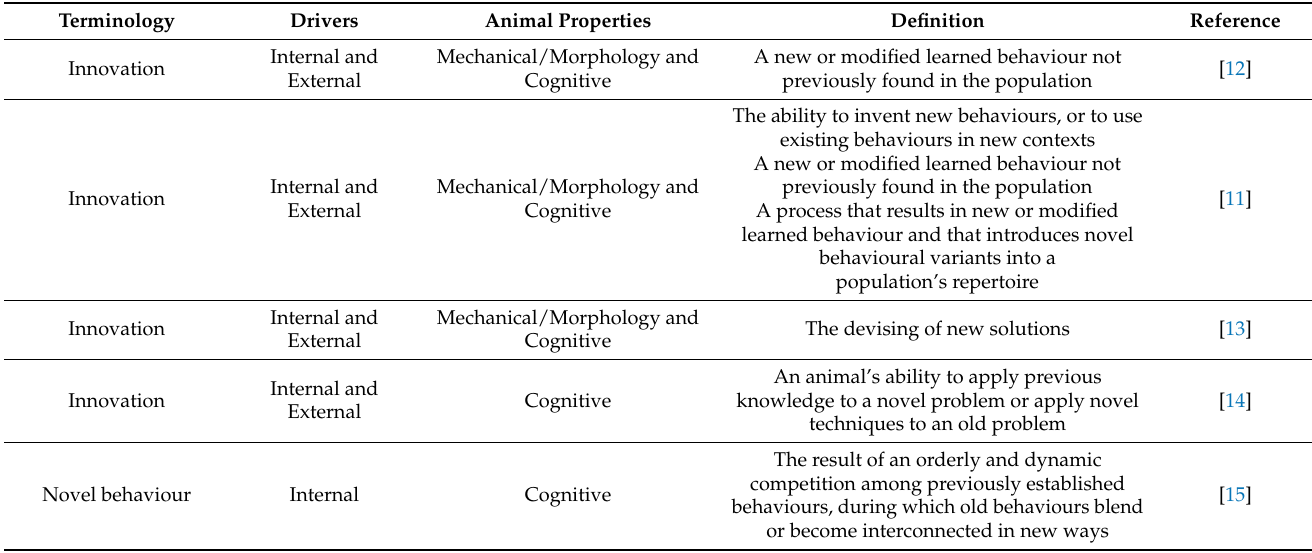
Table 1. Definitions of problem solving and innovation quoted from the literature and associated references. We highlight the drivers (i.e., whether the ability to problem solve is linked to internal (e.g., physiology, cognition) or external (e.g., environmental) factors) and the properties of the animal (mechanical/morphological abilities or cognitive abilities) that authors attribute to problem